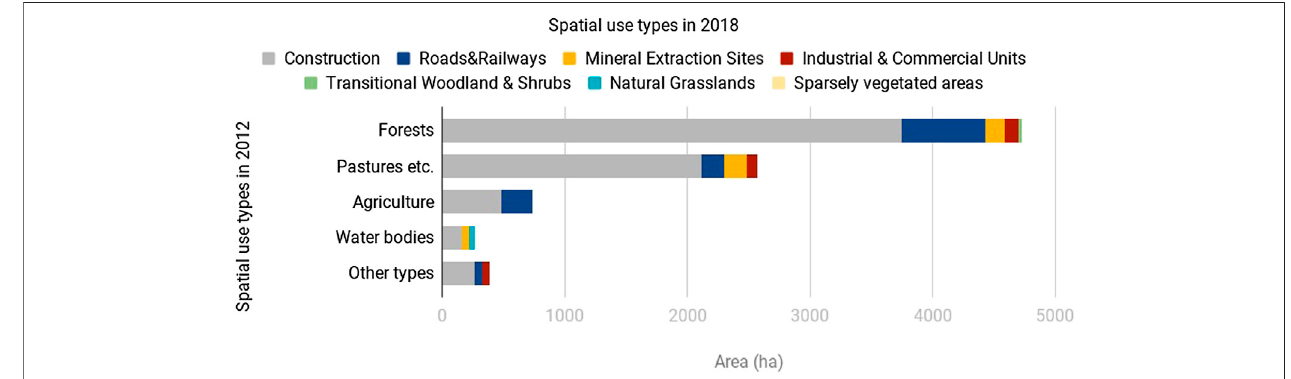
FIGURE 5 | Trade offs between spatial use types in 2012 – 2018 period.